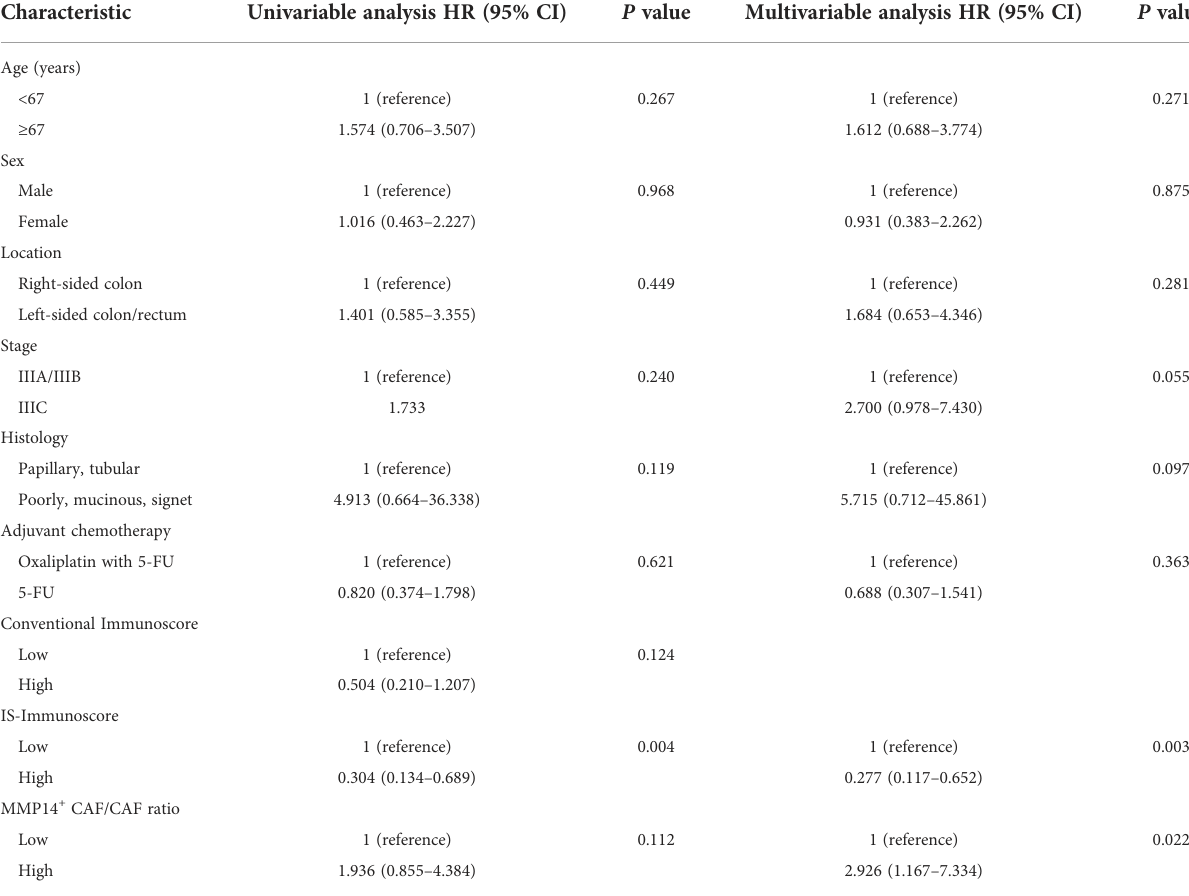
TABLE 2 Univariable and multivariable analysis of clinicopathologic factors for RFS ( n = 85).